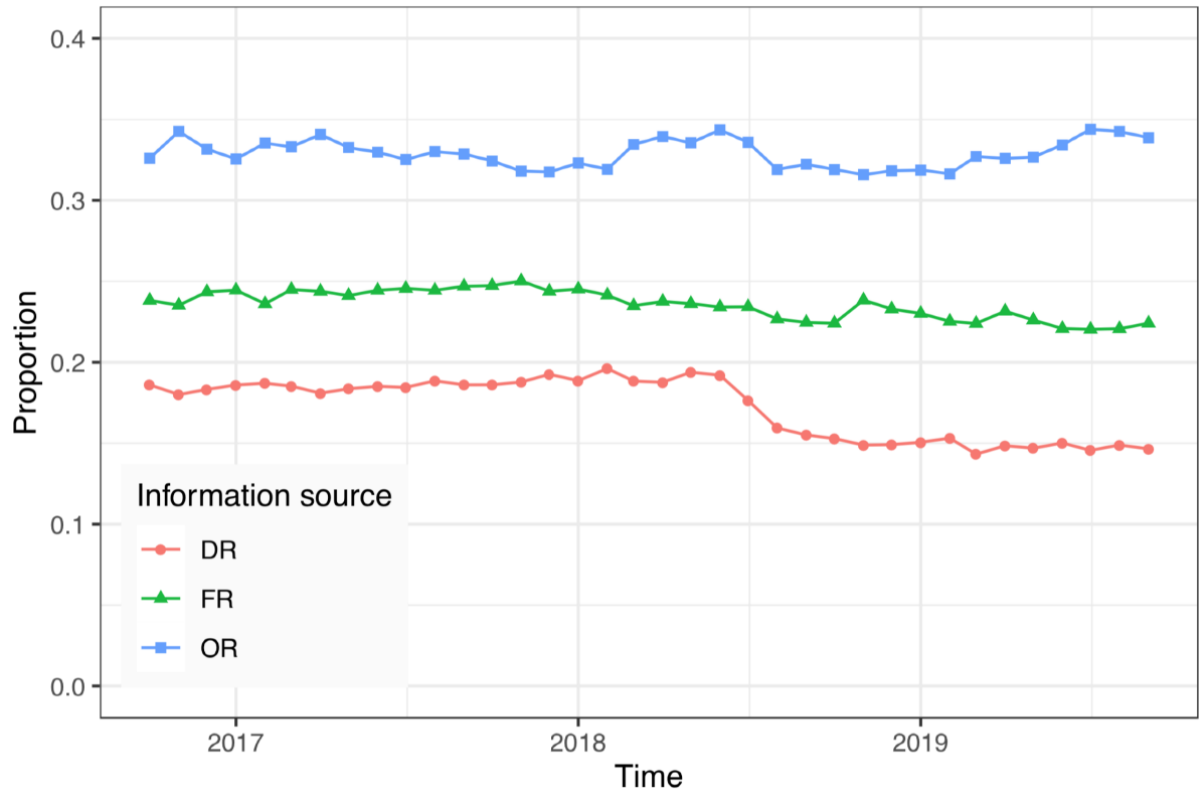
Figure 3. The proportions of the 3 main information sources in each month. DR: doctor recommendations; FR: family and friend recommendations; OR: online